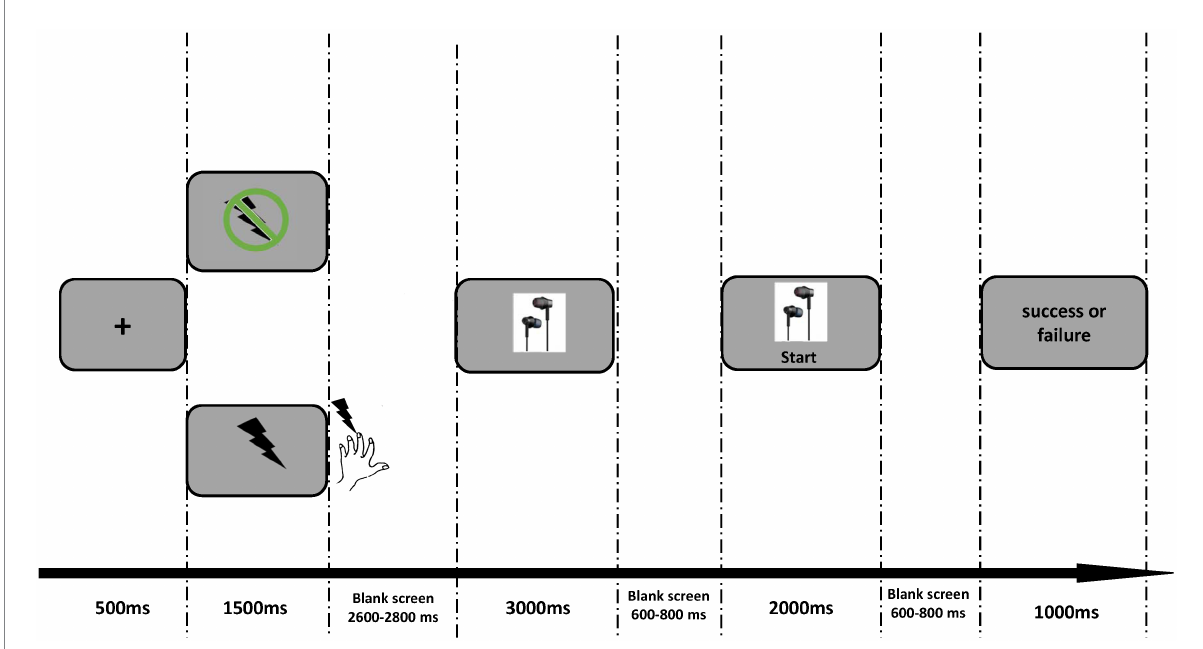
FIGURE 1 Experimental design. For each trial, the pain or nopain cue was firstly presented for 1,500 ms. Then the electrical shock (0.1 Hz) was conducted only after the pain cue disappeared. Following a 2,600–2,800 ms blank, the earphone picture appeared on the screen for at least 3,000 ms. The participants were told to press the number “2” on the keyboard as soon as the “start” button appeared. Finally, the system presented the feedback of success or failure for 1,000